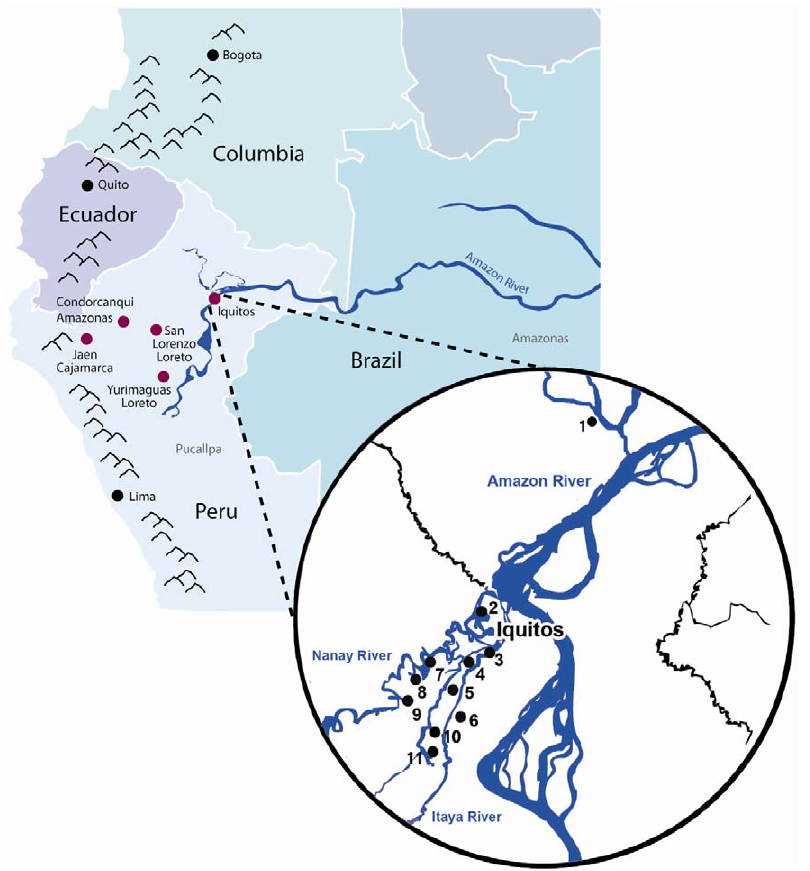
Figure 1. Map of Iquitos and the Peruvian Amazon. The locations of health centers in Iquitos where the P. falciparum samples were collected are shown in solid circles with numbers: 1, Mazan; 2, Moronacocha; 3, Cardozo; 4, San Juan de Miraflores; 5, 9 de octubre; 6, El progreso; 7, Santa Clara de Nanay; 8, Santo Tomas; 9, Zungarococha; 10, Moralillo; 11, Varillal. The locations where samples were collected in other Peruvian Amazon areas are shown as red dots. doi:10.1371/journal.pone.0008091.g001 The remaining 34 samples came from other areas in the Peruvian jungle as well as from different projects (Table 1). From this group, 12 samples were collected in Yurimaguas, located between the Maran˜on and Paranapura rivers (445 Km south of